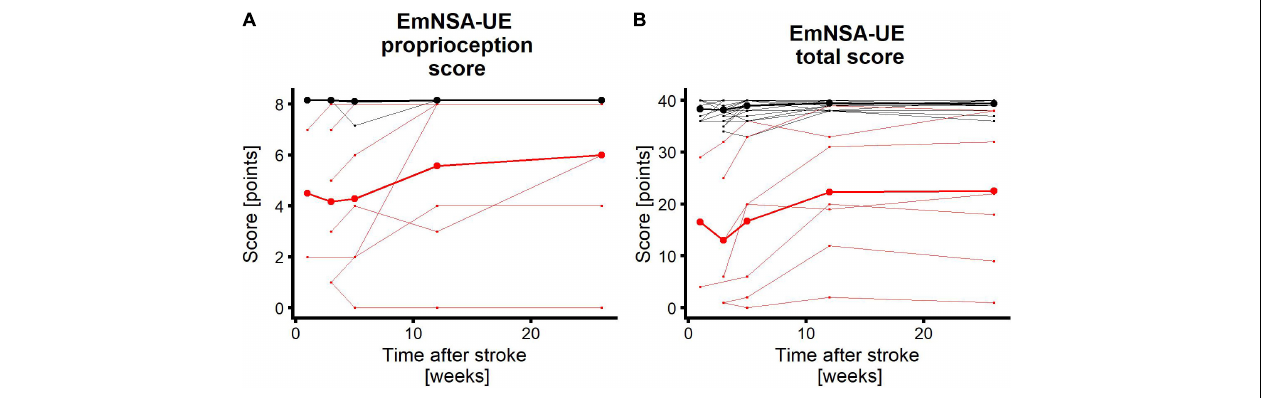
FIGURE 3 | Longitudinal recovery profiles. Red/black lines represent patients with impaired/unimpaired proprioceptive function within 3 weeks after stroke. Each thin line represents a single patient. Thick lines are mean recovery profiles within the two groups of patients. (A) EmNSA-UE proprioception score (EmNSA-UE p ) for all patients who participated in the clinimetric and EEG measurements up to week 26 after stroke. Maximum score is 8 points. Maximum value for unimpaired patients were added with 0.15 for plotting purposes. (B) EmNSA-UE total score (EmNSA-UE t ) for the same patients; maximum score is 40 points. Note that patients with unimpaired proprioceptive function largely overlap.